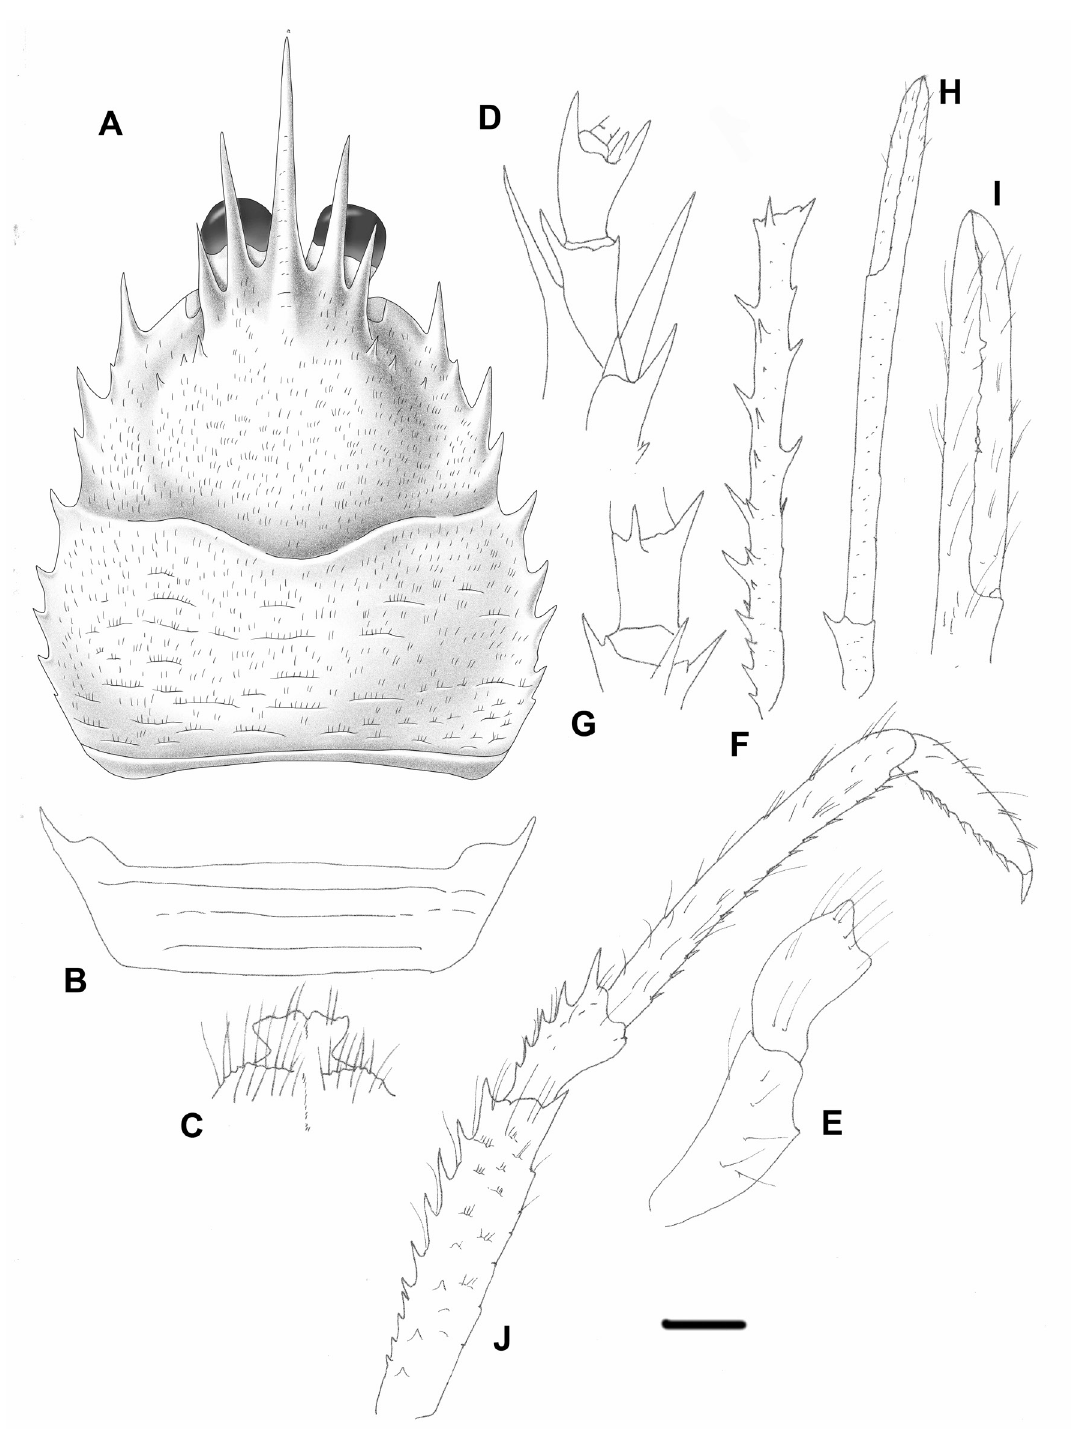
Fig. 1. Eumunida spiridonovi sp. nov., holotype, ♀, 11.0 mm (MNHN-IU-2016-8715), East of Somalia. A . Carapace, dorsal view. B . Abdomen, dorsal view. C . Sternal plastron, sternites 3 and 4. D . Left antenna and antennula, ventral view. E . Right Mxp3. F . Right P1 merus, dorsal view. G . Right P1 carpus and distal part of merus, ventral view. H . Right P1 palm and fingers, dorsal view. I . Right P1 distal part of palm and fingers, ventral view. J . Right P2. Scale bar: A–C, G, I–J = 2.0 mm; D–E = 1 m; F, H = 0.5